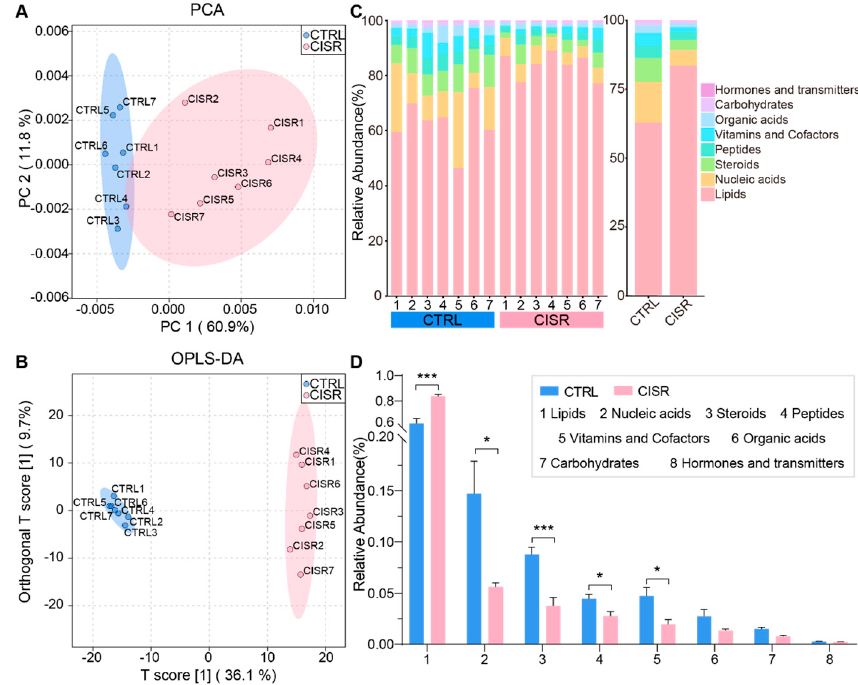
Figure 5. CISR perturbed the fecal metabolic profiles. ( A , B ) The fecal metabolite profiles of the CTRL and CISR mice differentiated by a principal component analysis (PCA) and an orthogonal partial least squares discrimination analysis (OPLS − DA). ( C , D ) CISR altered the relative abundance of all fecal metabolites, as shown by a percentage stacking histogram and a comparison via Student’s t -test. The values were presented as the mean ± SEM. Significant differences were indicated by asterisks (*** p < 0.001, * p < 0.05).